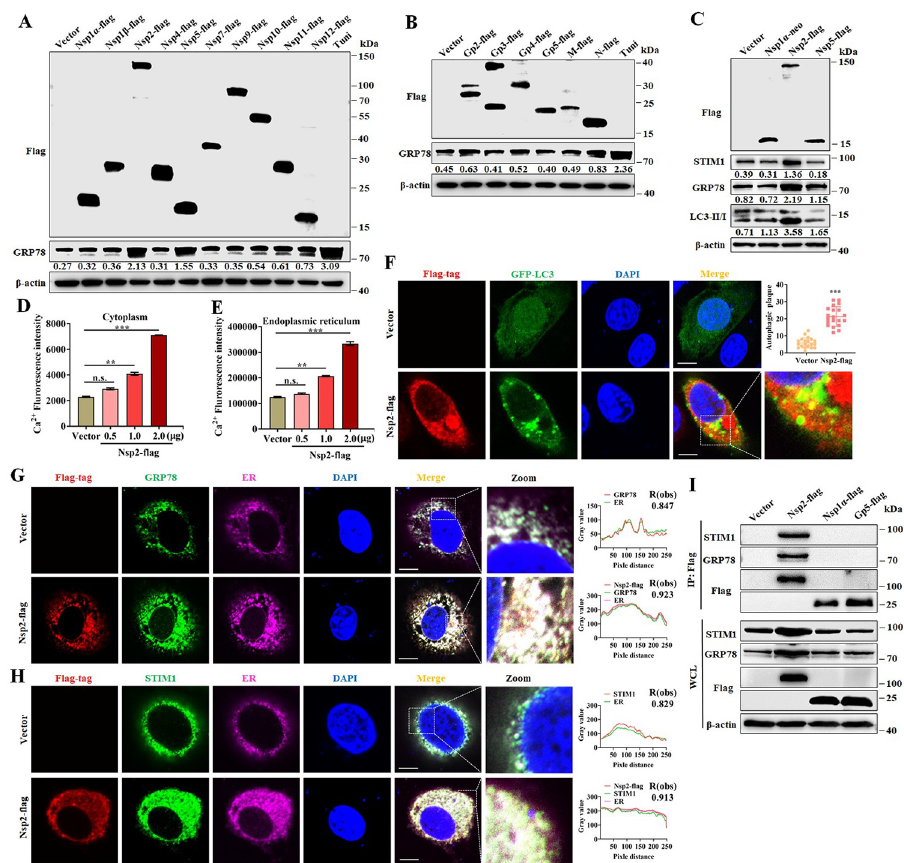
Fig 8. PRRSV Nsp2 interacts with STIM1 and GRP78, induces autophagy. (A and B) The effect of viral non- structural and structural proteins on ER stress. Marc-145 cells were transfected with plasmids encoded non-structural ( A ) and structural ( B ) proteins for 24 h. Cell lysates were harvested for western blotting with antibodies against Flag, GRP78 and β -actin. (C-H) PRRSV Nsp2 induces ER stress and autophagy. ( C ) Marc-145 cells were transfected with pCI-Nsp2-flag or empty vector (pCI-neo) for 24 h then cell lysates were analyzed by western blotting for Flag, STIM1, GRP78, LC3-I/II, and β -actin. (D-E) Marc-145 cells were transfected with pCI-neo or increasing doses of pCI-Nsp2-flag for 24 h. ( D ) Cytoplasmic Ca 2+ and ( E ) ER Ca 2+ levels were determined by fluorescence of Fluo-8. ( F ) Marc-145 cells were transfected with pCI-Nsp2-flag or pCI-neo together with GFP-LC3 for 24 h. Cells were stained for Flag, nuclei were stained with DAPI, and cells were observed by confocal microscopy. The numbers of GFP-LC3 dots were quantified from 20 different cells in each group. ( G ) Colocalization of Nsp2 and GRP78 at ER. Cells were stained for Flag, GRP78, Calnexin (ER marker) and nuclei were stained with DAPI; cells were observed by confocal microscopy. Scale bar, 5 μ m. ( H ) Colocalization of Nsp2 and STIM1 at ER. Cells were stained for Flag, STIM1, Calnexin (ER marker) and nuclei were stained with DAPI; cells were observed by confocal microscopy. Scale bar, 5 μ m. ( I ) PRRSV Nsp2 is associated with GRP78 and STIM1. Marc-145 cells were transfected with pCI-Nsp2-flag, pCI-Nsp1 α -flag, pCI-GP5-Flag or pCI-neo for 24 h. Cell lysates were immunoprecipitated with anti-Flag antibody, and then subjected to western blot analysis for Flag, STIM1 GRP78, and β -actin. The protein levels were quantified by Image J and normalized to β -actin. The data are representative of results from three independent experiments. Error bars indicate the mean ( ± SD) of three repeats. * , p < 0.05; ** , p < 0.01; and *** , p <